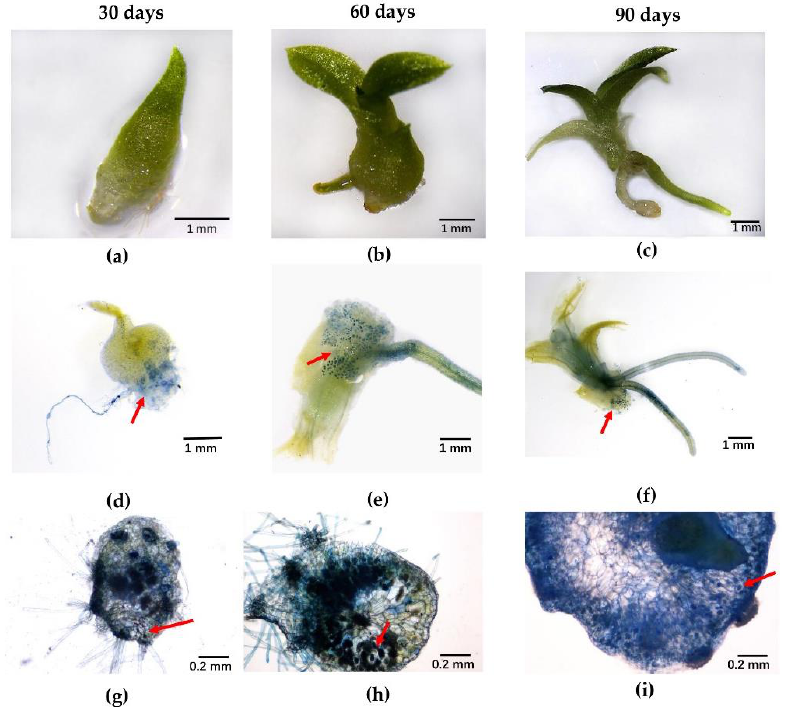
Figure 4. The colonization of strain T12 in D. crepidatum protocorms during 90 days of co-culture. The growth of the D. crepidatum protocorms into seedlings in co-culture at 30 days ( a ), 60 days ( b ), and 90 days ( c ). Pelotons were observed in a stereomicroscope using trypan blue staining at 30 days ( d ), 60 days ( e ), and 90 days ( f ) of co-culture; Cross-section of the symbionts that were observed in the light microscope using trypan blue staining at 30 days ( g ), 60 days ( h ), and 90 days ( i ) of co- culture. Bar: ( a – f ) 1 mm, ( g – i ) 0.2 mm. The red arrows point to the pelotons.